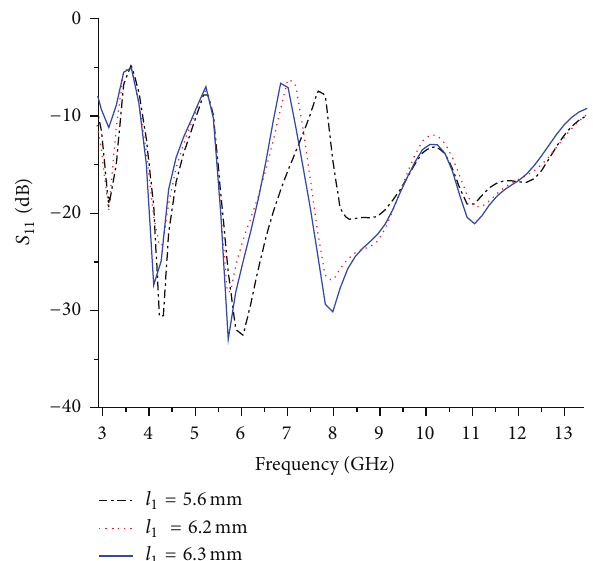
Figure 6: The effect of 𝑙 1 on 𝑆 11 of the proposed antenna.